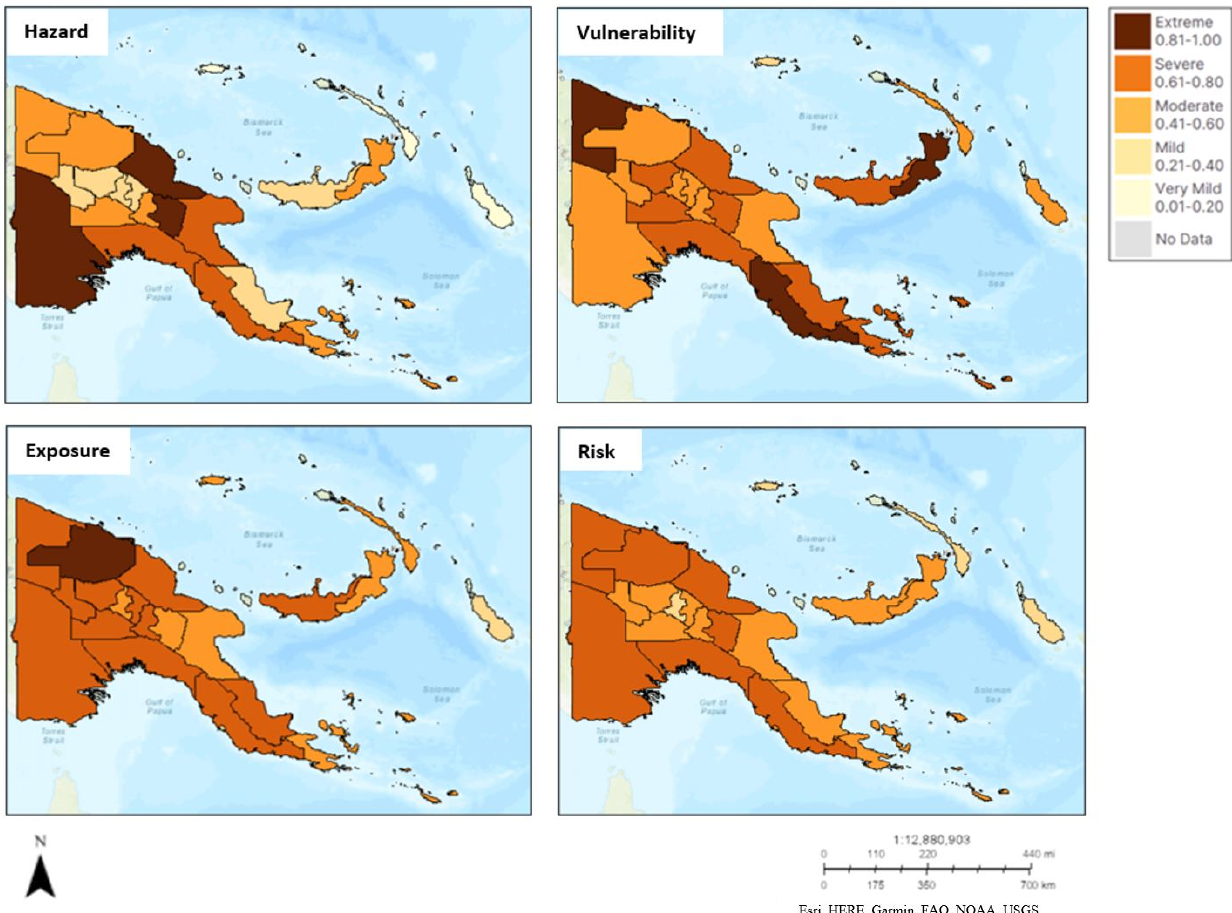
Figure 5. Overall drought risk maps of PNG provinces for 2014 including a drought hazard, drought vulnerability, drought exposure, and drought risk map detailing the index level of each province. The index level is classified on a deepening orange colour scale from very mild (index values from 0.01–0.20) to extreme (index values from